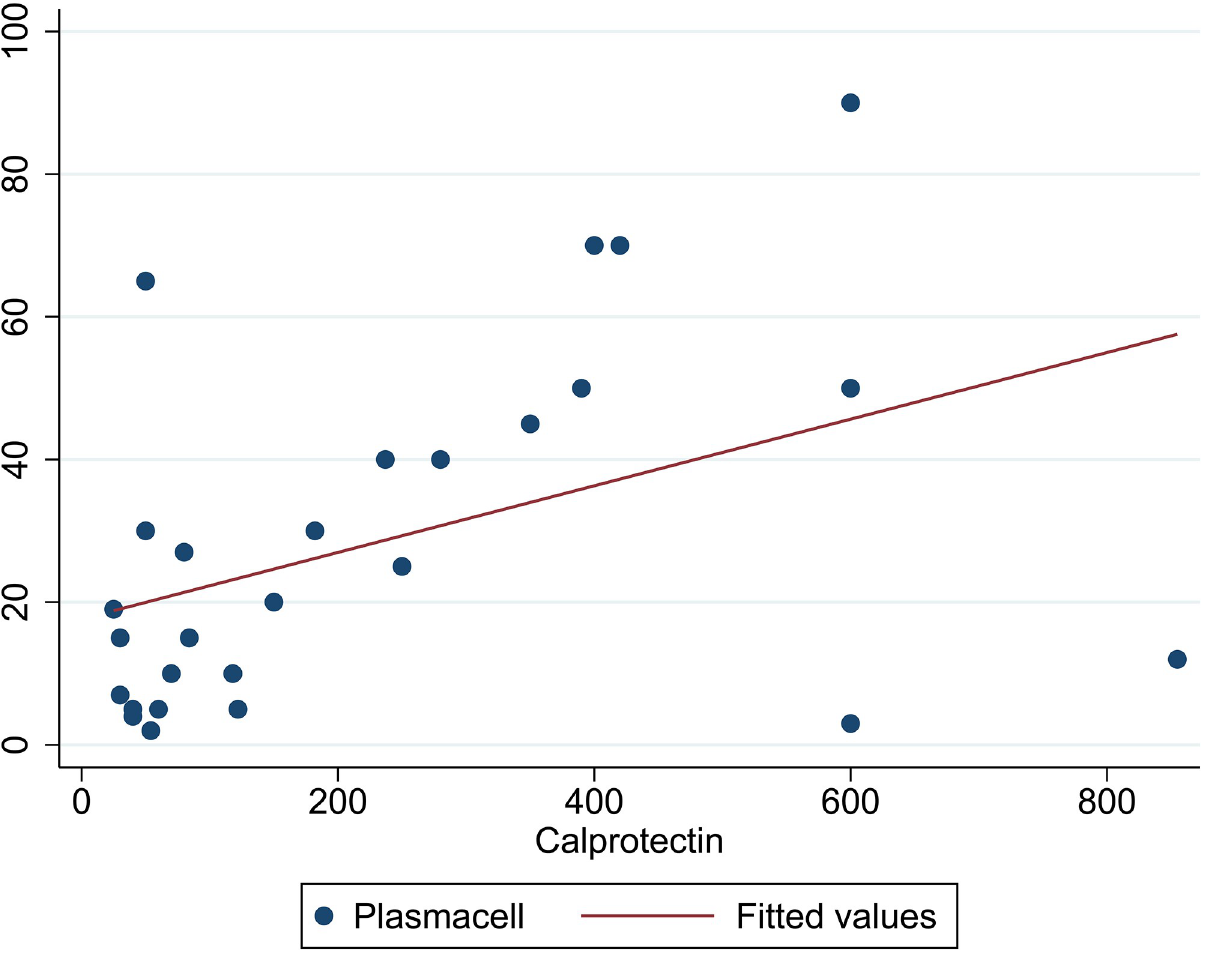
Fig 3. The correlation of plasma cell and CP among patients with MM (n =